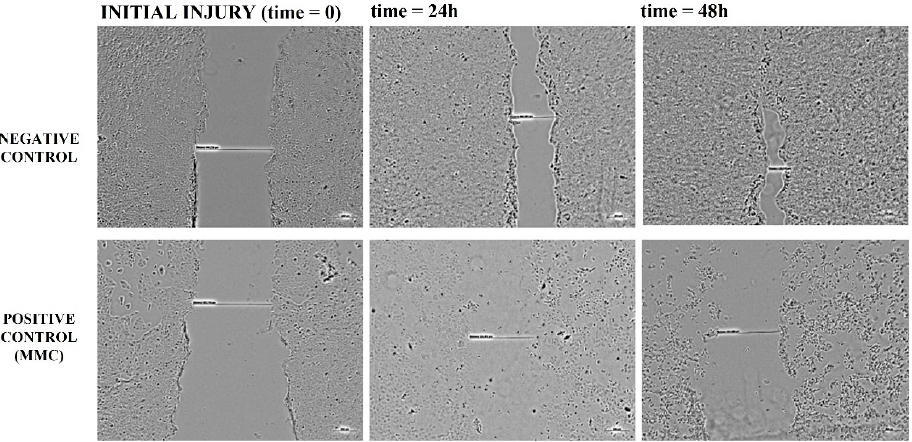
Figure 7. Wound healing assay: control group photomicrographs.